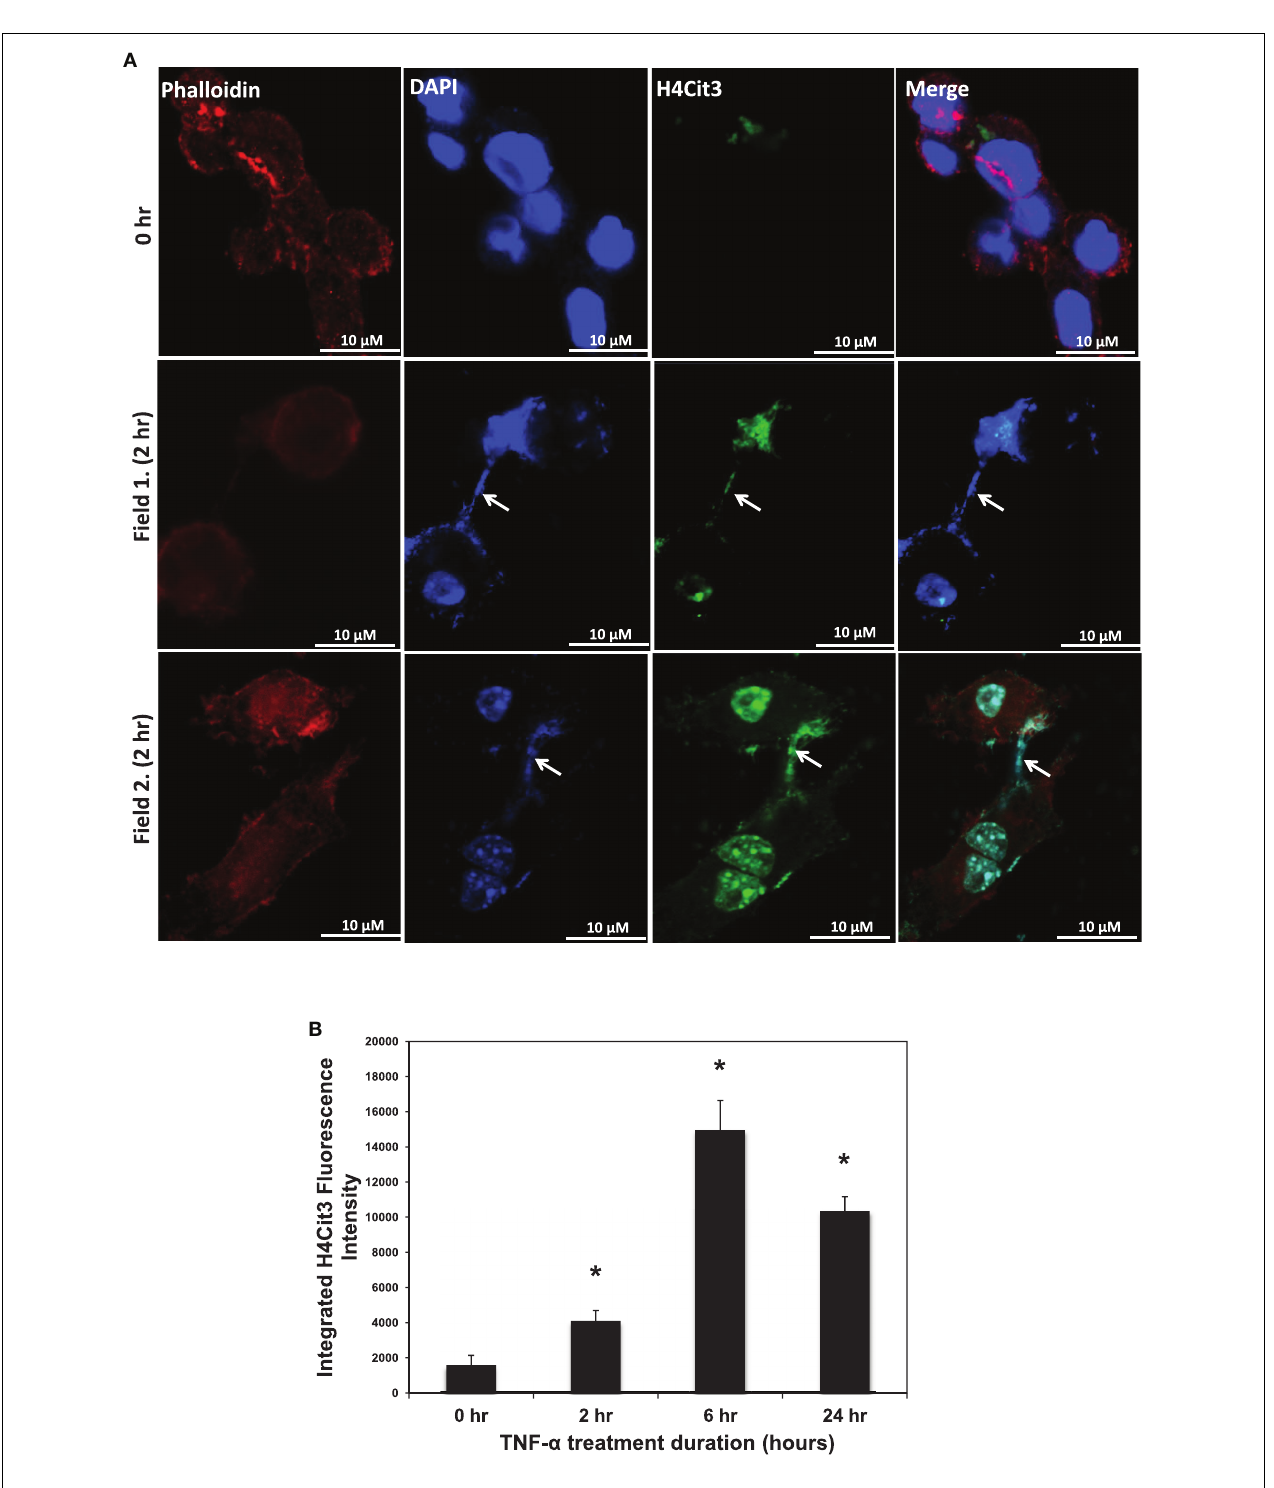
fluorescence intensity quantitation at 0, 2, 6, and 24h ofTNF- α treatment.The RAW 264.7 macrophages were treated with 20ng/ml of TNF- α , fixed, stained with the anti-H4Cit3 antibody, and imaged by indirect immunofluorescence at the indicated time points. Five unique fields were imaged by confocal microscopy at each time point and the mean integrated fluorescence intensity was calculated using ImageJ software analysis. Results were analyzed by ANOVA and the graphs represent mean ± standard deviation (* p -value <